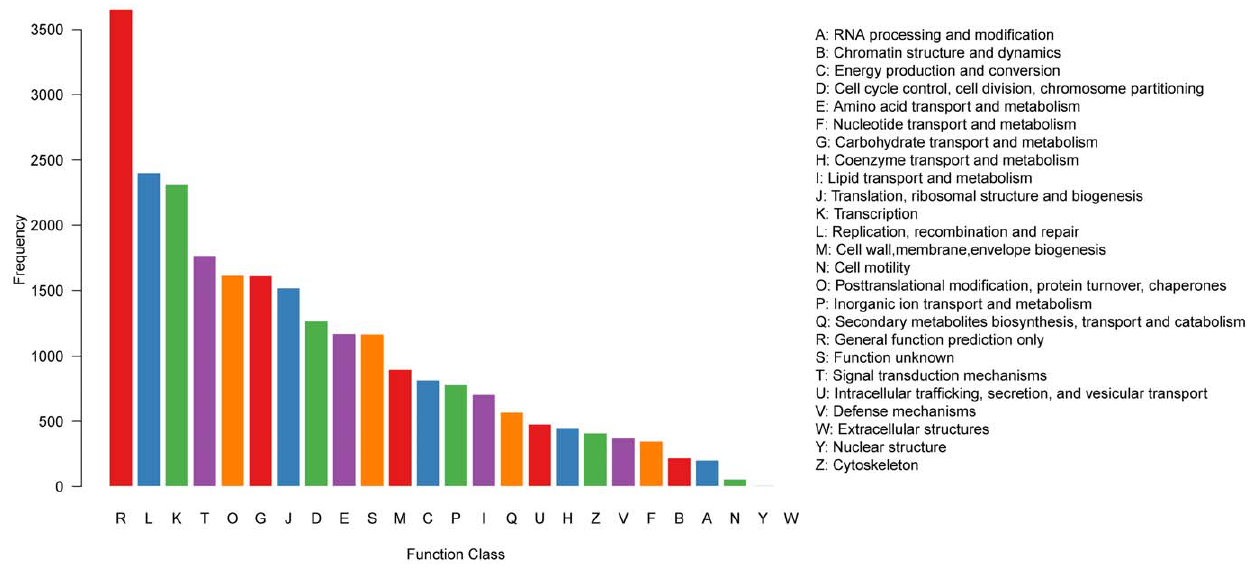
Figure 5. COG functional classifications of the D.latiflorus flower transcriptome.